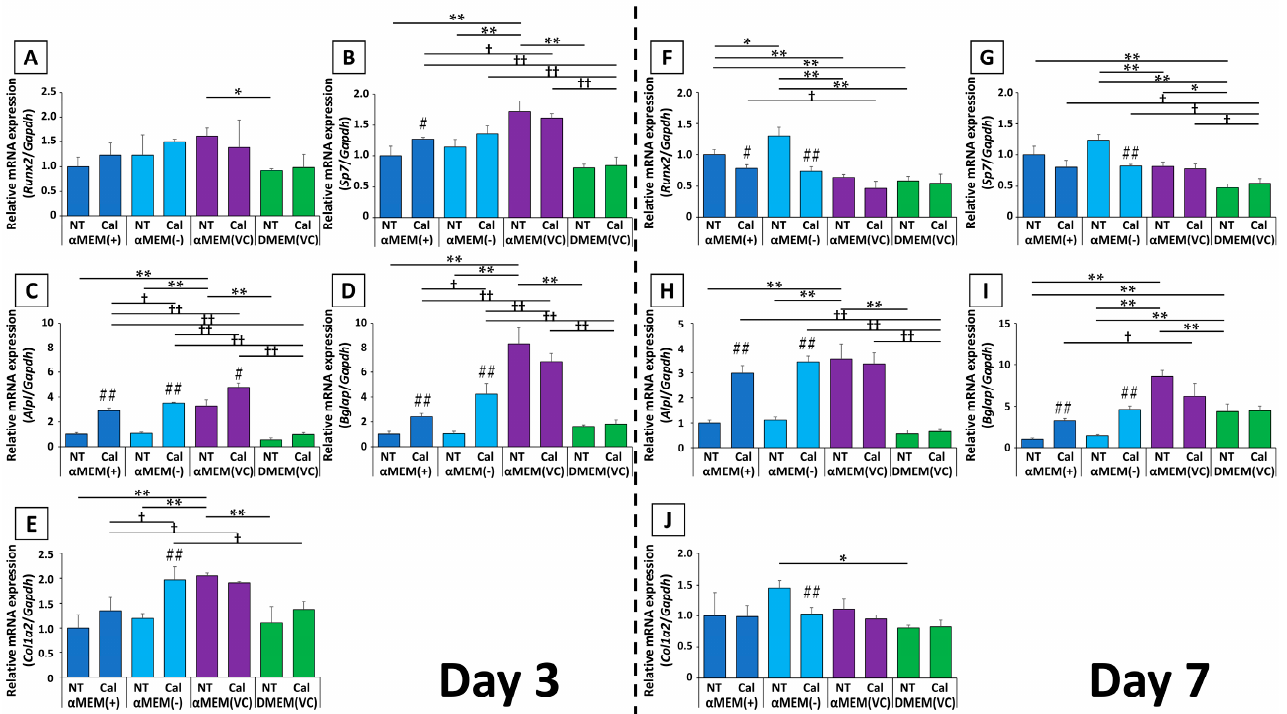
Figure 4. Comparative qPCR for ( A , F ) Runx2 , ( B , G ) Sp7 , ( C,H ) Alpl , ( D , I ) Bglap , and ( E , J ) Col1a2 on days 3 and 7 after calcification induction. Target-gene expression was normalized to Gapdh expression and was calculated by comparing the expression in MC3T3-E1 cells cultured in nontreated α MEM (+) ( n = 3, * p < 0.05, ** p < 0.01, † p < 0.05, †† p < 0.01, # p < 0.05, ## p < 0.01): * multiple group comparison among nontreated (NT) media; † multiple group comparison among calcification (Cal) media; # two group comparison between NT and Cal media.